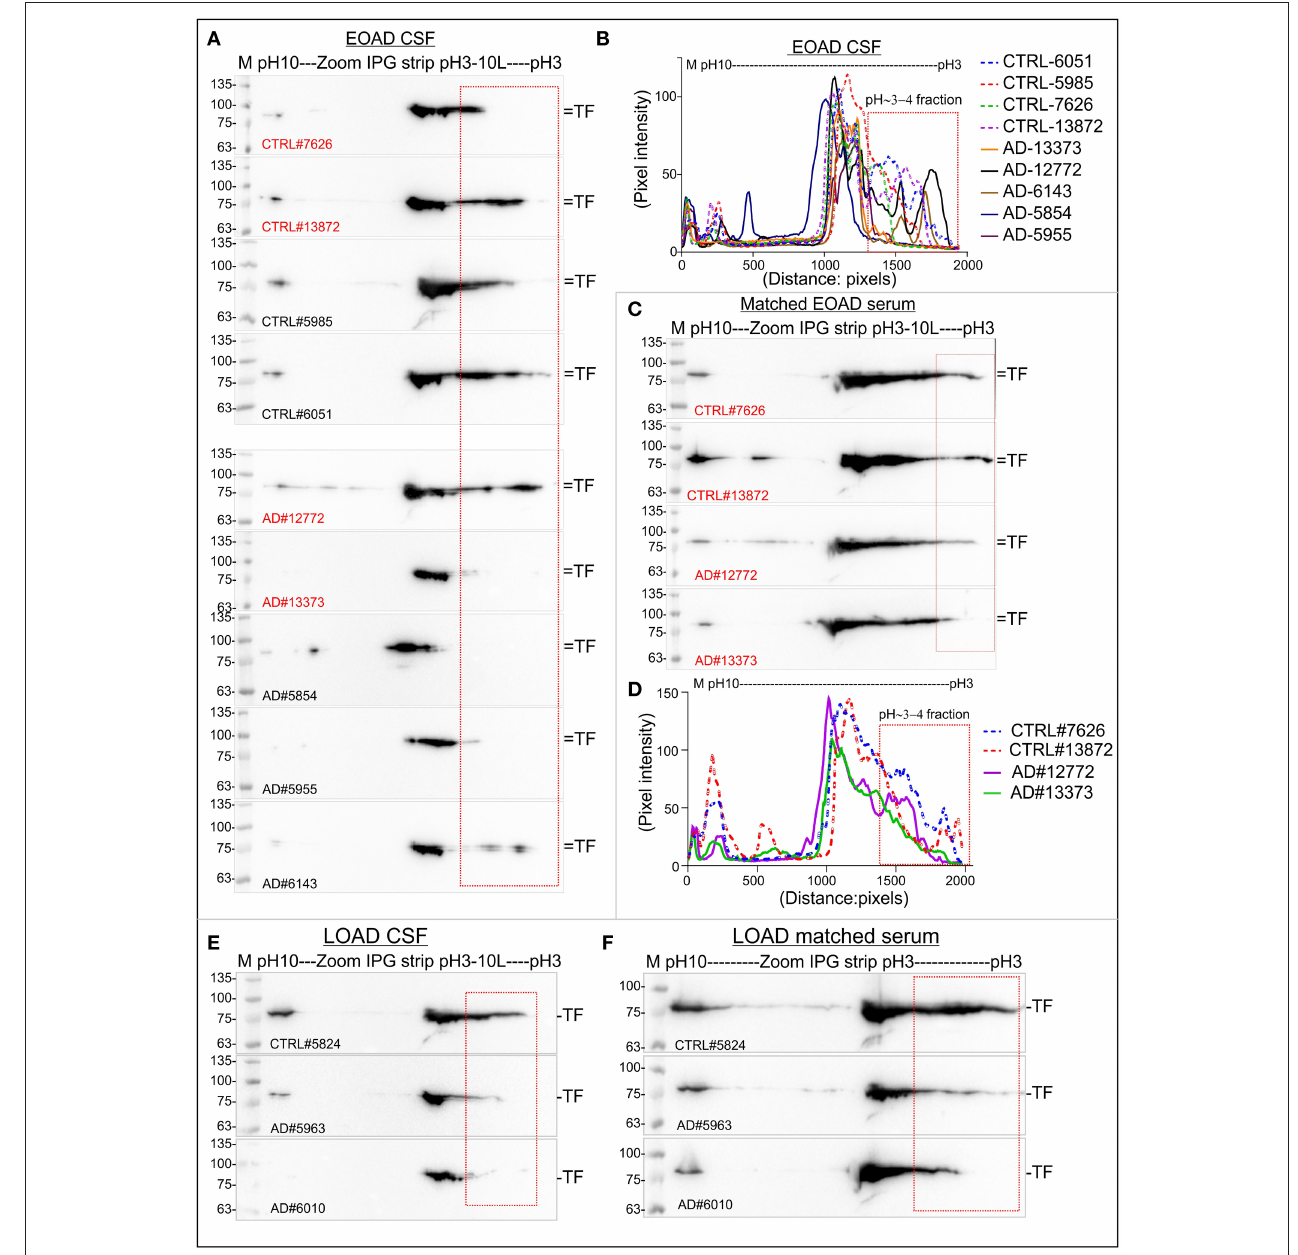
FIGURE 10 | Relative abundance of P-TF reduced in the CSF and serum of postmortem human EOAD and LOAD patients compared to the controls. (A,C,E,F) Immunoblots showing charged fractions of TF in the CSF and serum samples of postmortem human EOAD and LOAD patients and unaffected controls. (B,D) plot profile of the immunoblots presented in (A,C) . The plot profile was created using ImageJ. Red marked are represents P-TF (pH ∼ 3-4 fractions). Detailed sample information is given in Table 3 . The Red highlighted samples represent matched serum and CSF collected from same individual.